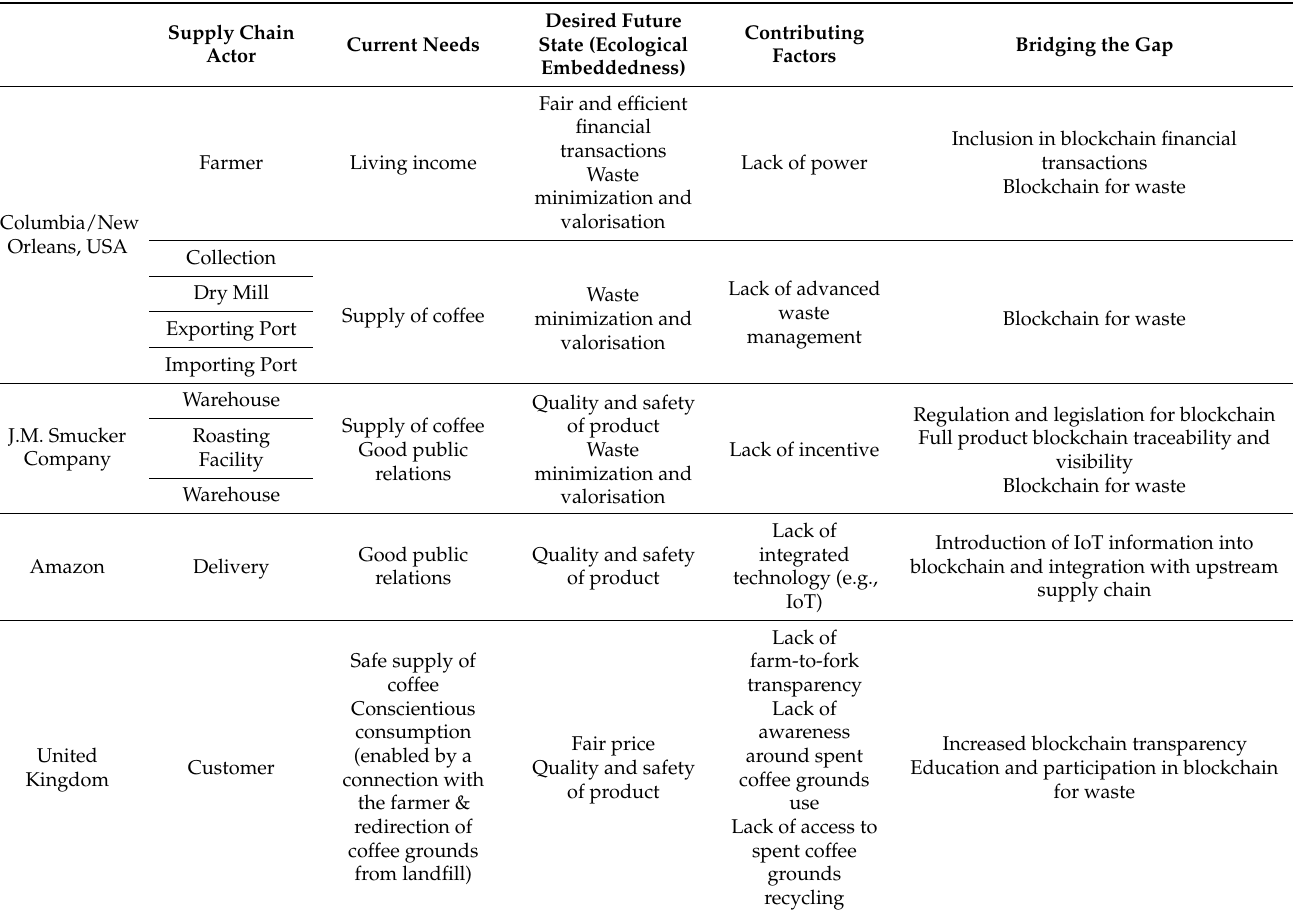
Table 1. Gap analysis of Folgers 1850